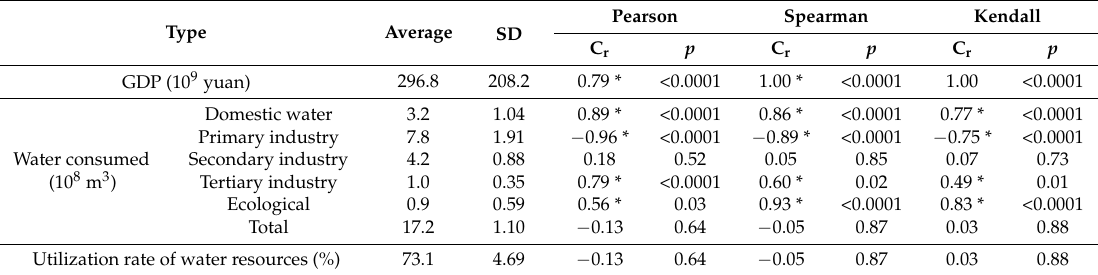
Table 2. Correlations between urbanization rate ( U r ) and GDP in five uses of water and the utilization rate of water resources. Type Average SD